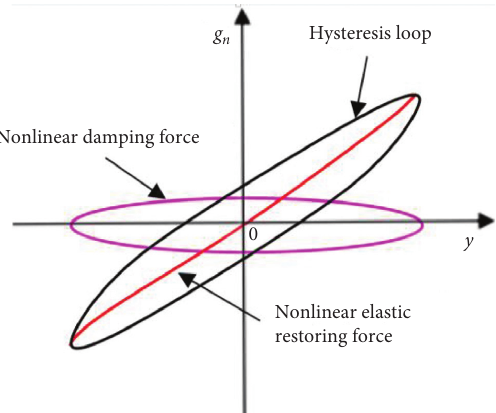
Figure 9: Exact decomposition of the hysteresis